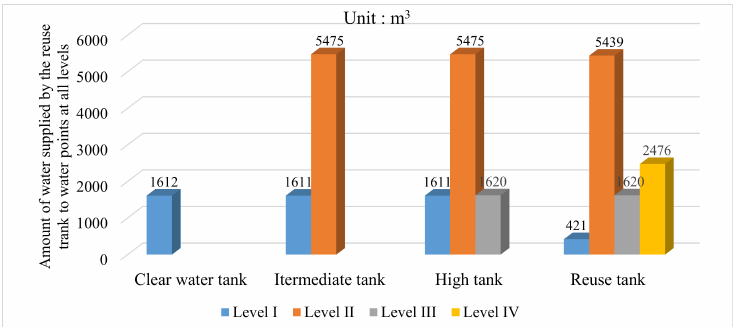
Figure 14. Statistical chart of mine water reuse scheduling in nonheating